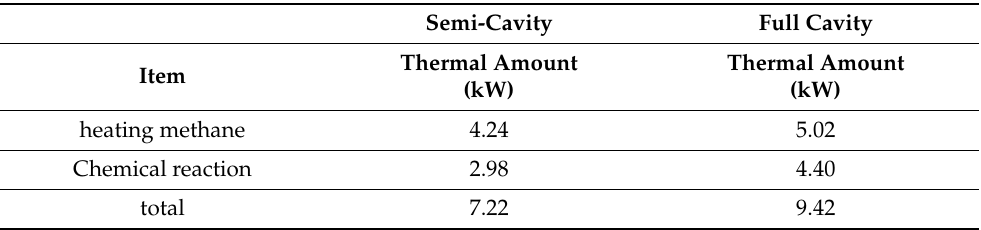
Table 6. Thermal amount for heating and chemical reaction according to cavity